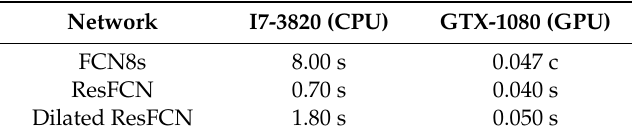
Table 3. Mean processing time of a single image, without test-time augmentation, using CPU and